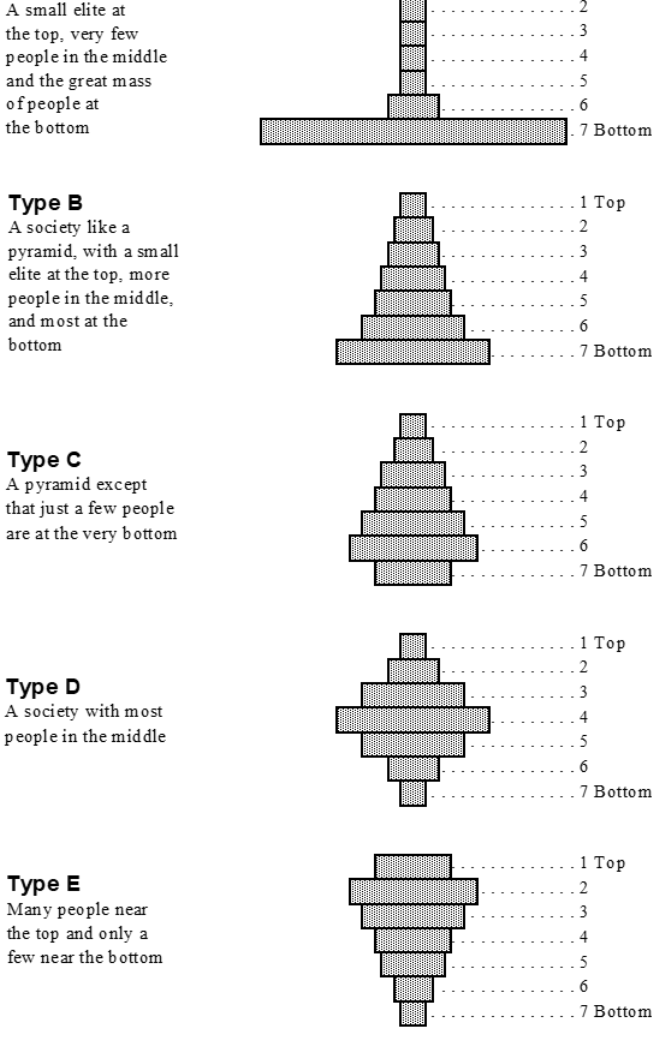
Figure 6. The inequality perception question as shown to respondents.